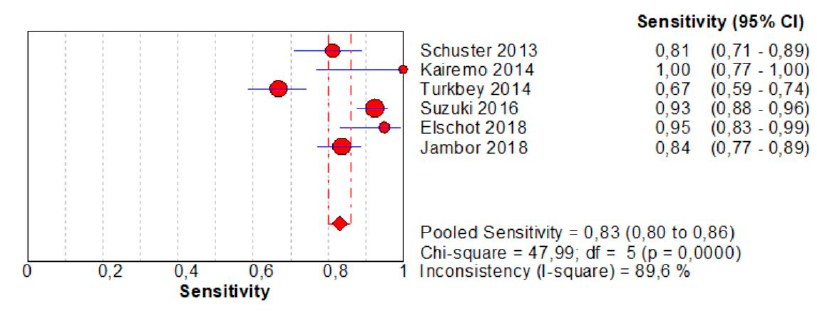
(Figure 2e). The SROC curve indicates that the area under the cure was: 0.9224 (Figure